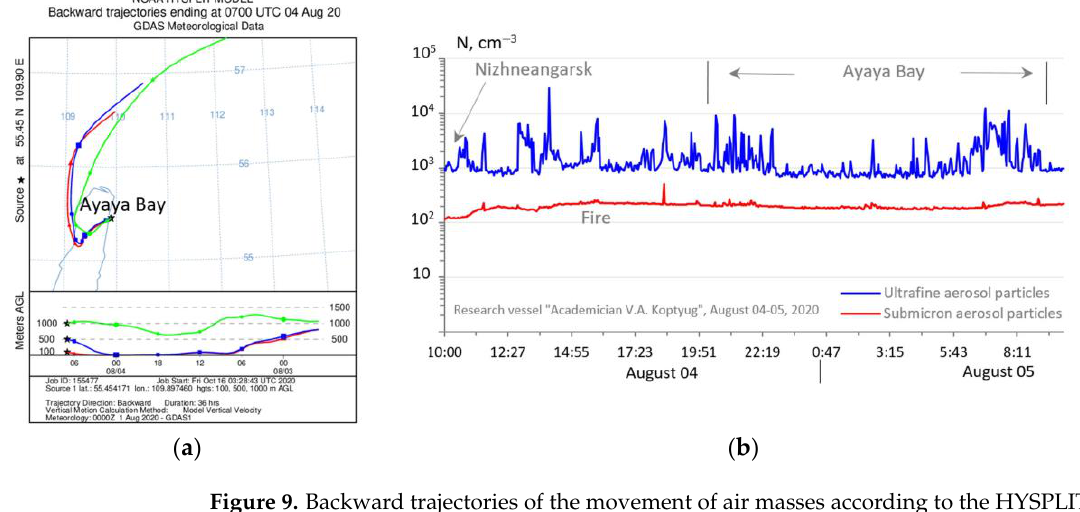
Figure 9. Backward trajectories of the movement of air masses according to the HYSPLIT model ( a ); the time course of the concentration of ultrafine and submicron aerosol in the near-water of Lake Baikal in the period 4 – 5 August 2020 ( b ).